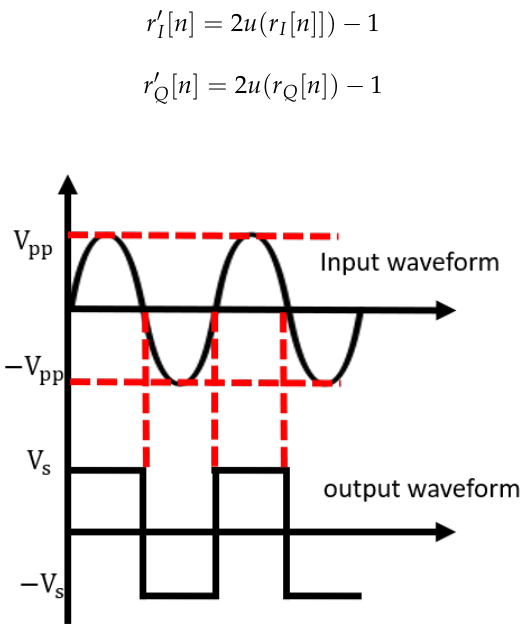
Figure 4. Operation of the zero-crossing